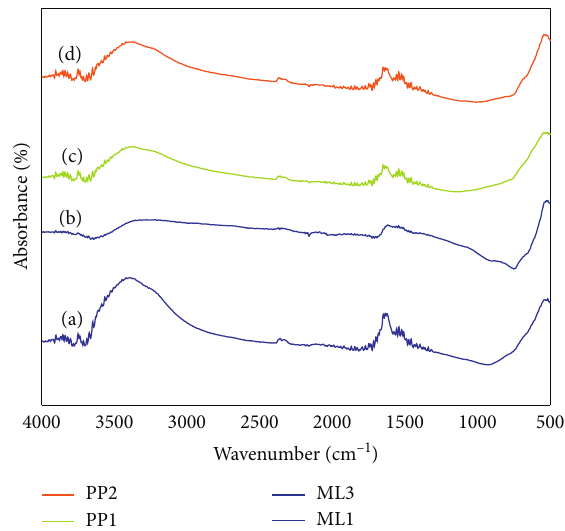
Figure 2: FTIR of plantain peels and maize leaves synthesized. (a) ML1-Fe 3 O 4 NP. (b) ML3-Fe 3 O 4 NP. (c) PP1-Fe 3 O 4 NP. (d) PP3-